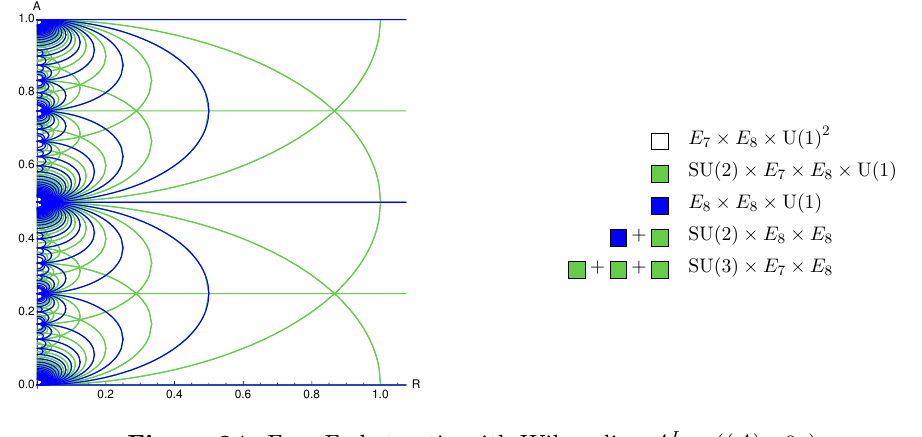
Figure 24. (cid:0) 8 (cid:2) (cid:0) 8 heterotic with Wilson line A I = (( A ) 8 ; 0 8